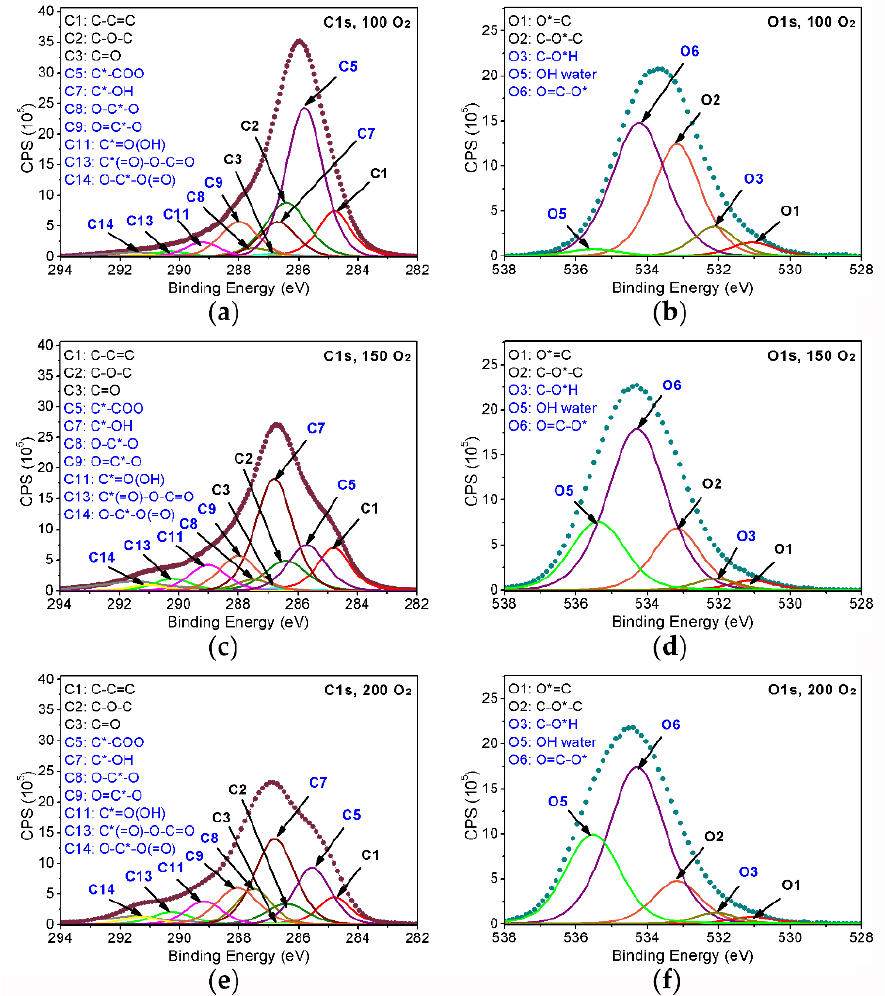
Figure 6. XPS spectra of PEEK modified with EUV radiation and oxygen plasma: ( a ) C1s band—100 EUV pulses, ( b ) O1s band—100 EUV pulses, ( c ) C1s band—150 EUV pulses, ( d ) O1s band—150 EUV Table 2. The atomic concentration of carbon, nitrogen, and oxygen for unmodified PEEK and modified PEEK. Elements